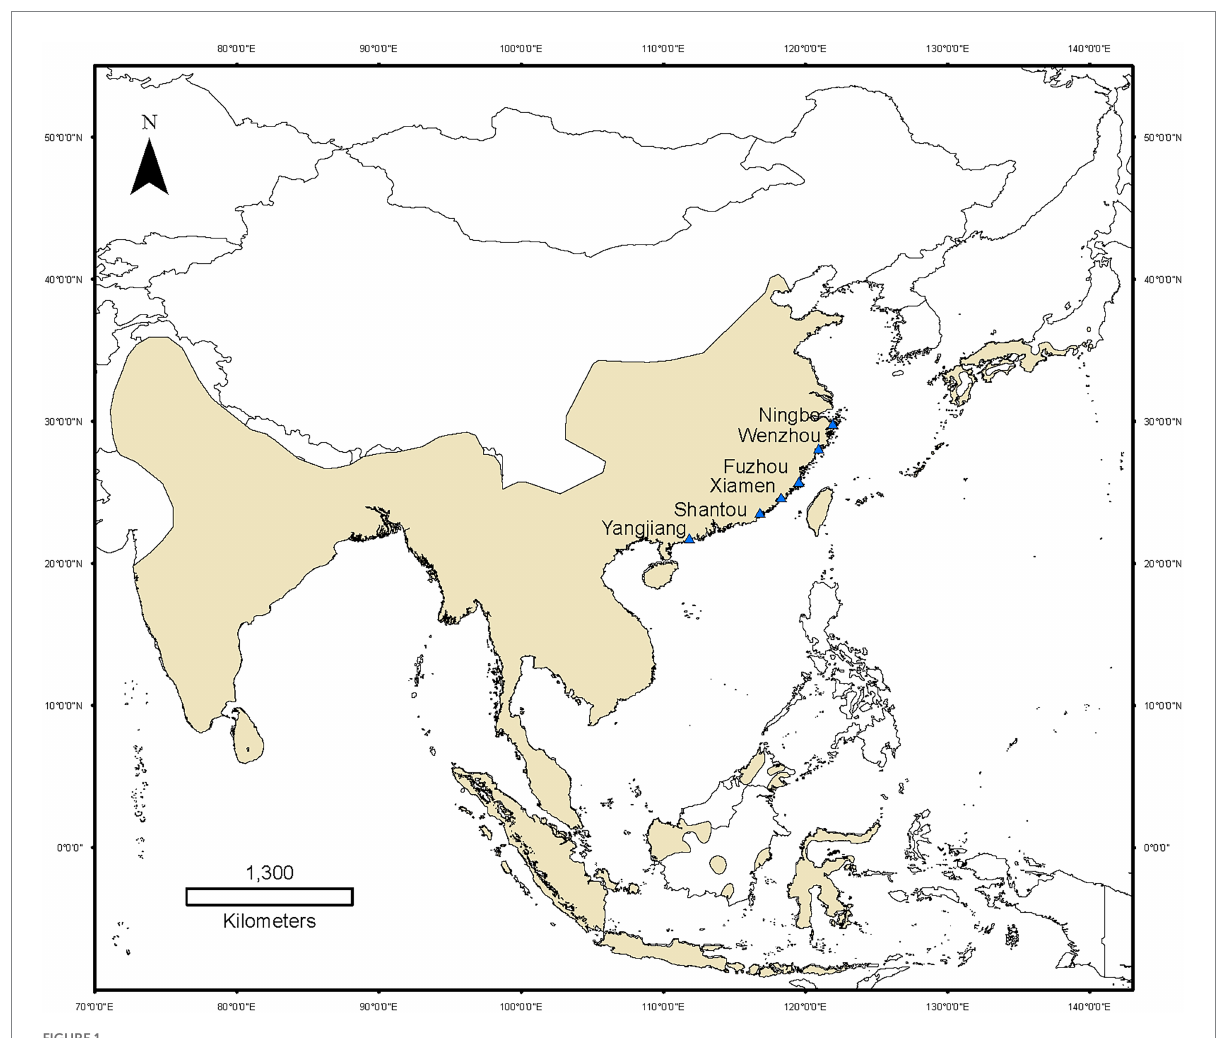
FIGURE 1 Map of Fejervarya limnocharis populations sampled along the eastern coast of mainland China. Yellow areas indicate the global distribution of F. limnocharis . Blue triangle denotes the sampling